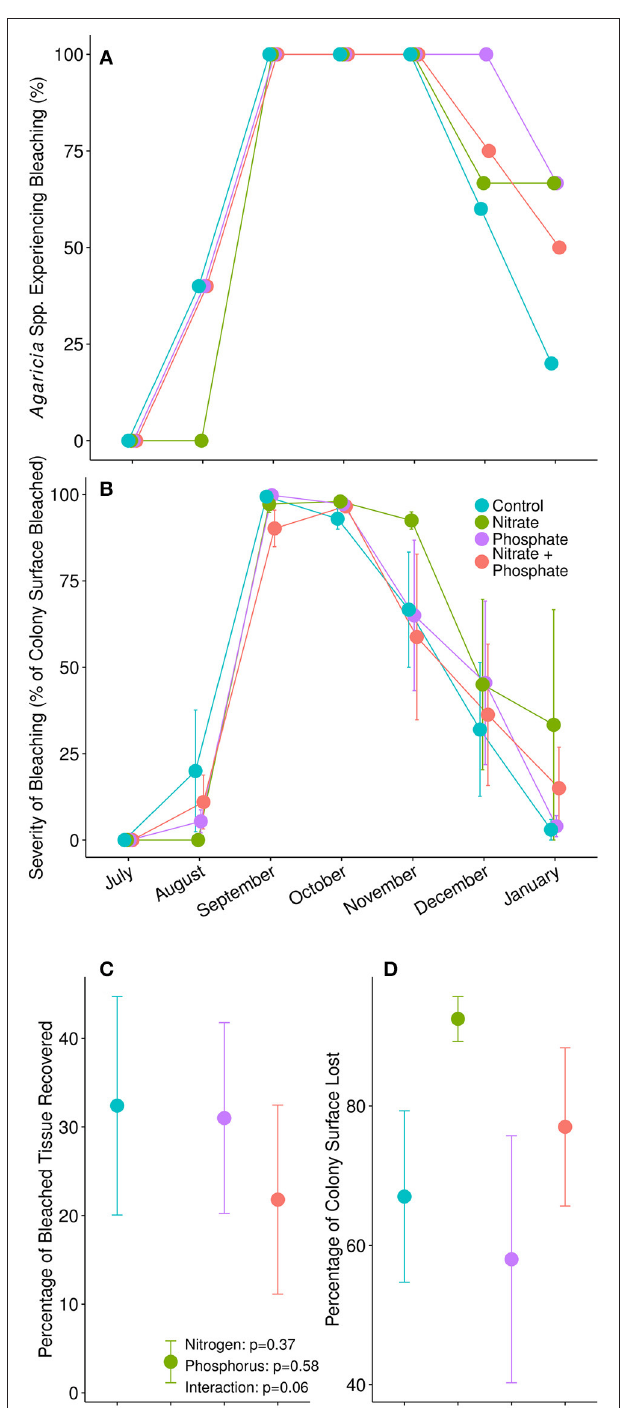
FIGURE 2 | (A) Proportion of Agaricia spp. in each treatment experiencing bleaching during our monthly surveys. (B) The average severity of bleaching, calculated as the percentage of colony surface area with no pigmentation, during each survey point. (C) The average percentage of previously bleached tissue in each colony that had regained pigment and recovered from bleaching by January, 2015. P -values are from a two-factor ANOVA. (D) The average percentage of each coral’s surface area that died between pretreatment surveys in July, 2014, and final surveys in January,